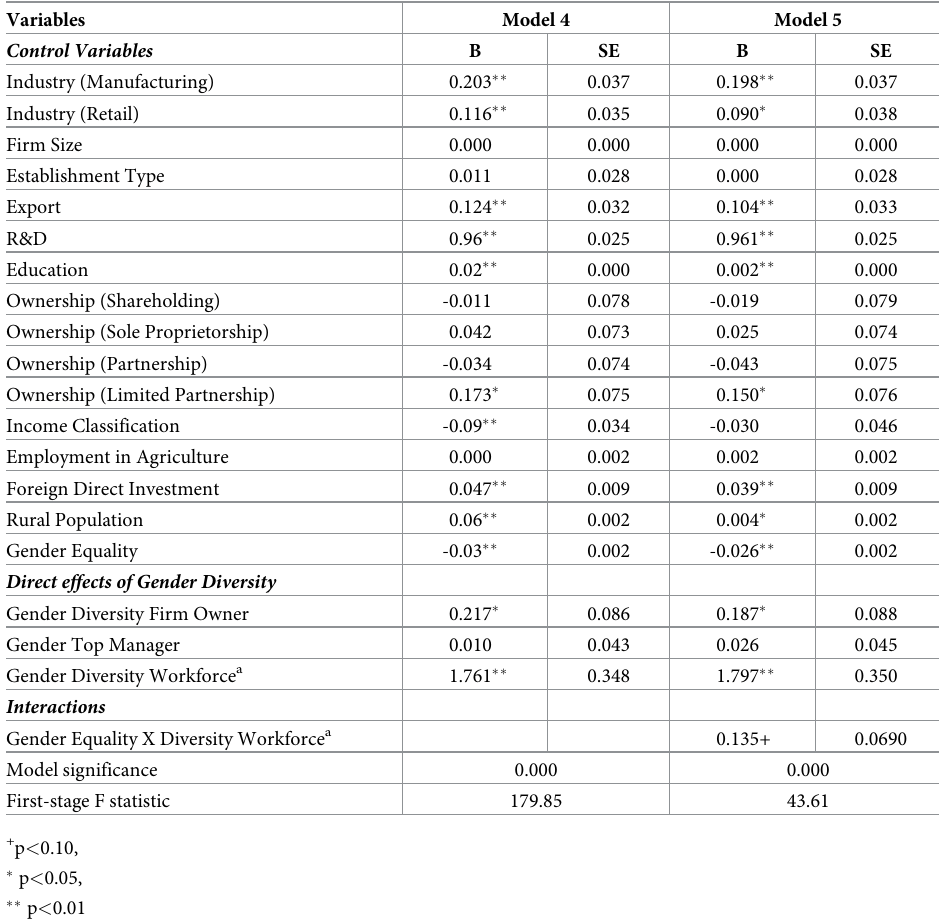
Table 5. Instrumental variable regressions for gender diversity in the workforce (n = 18